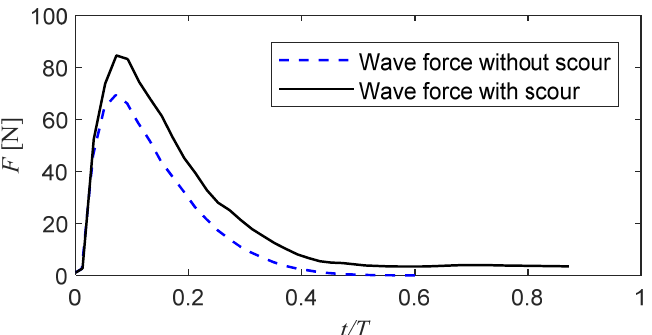
Figure 9. Comparison of wave force on the structure mounted on the rigid bed and scoured bed.